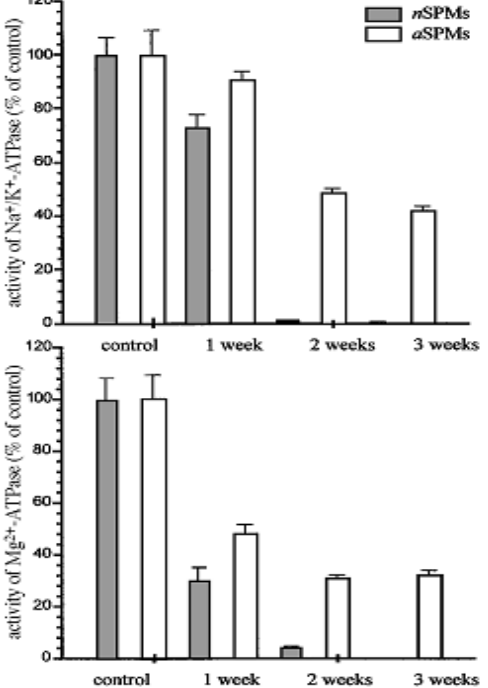
Figure 9 . Stability of the Na + ,K + -ATPase and Mg 2+ -ATPase activity of nSPM and aSPM as a function of time after the adsorption (weeks). Reproduced from